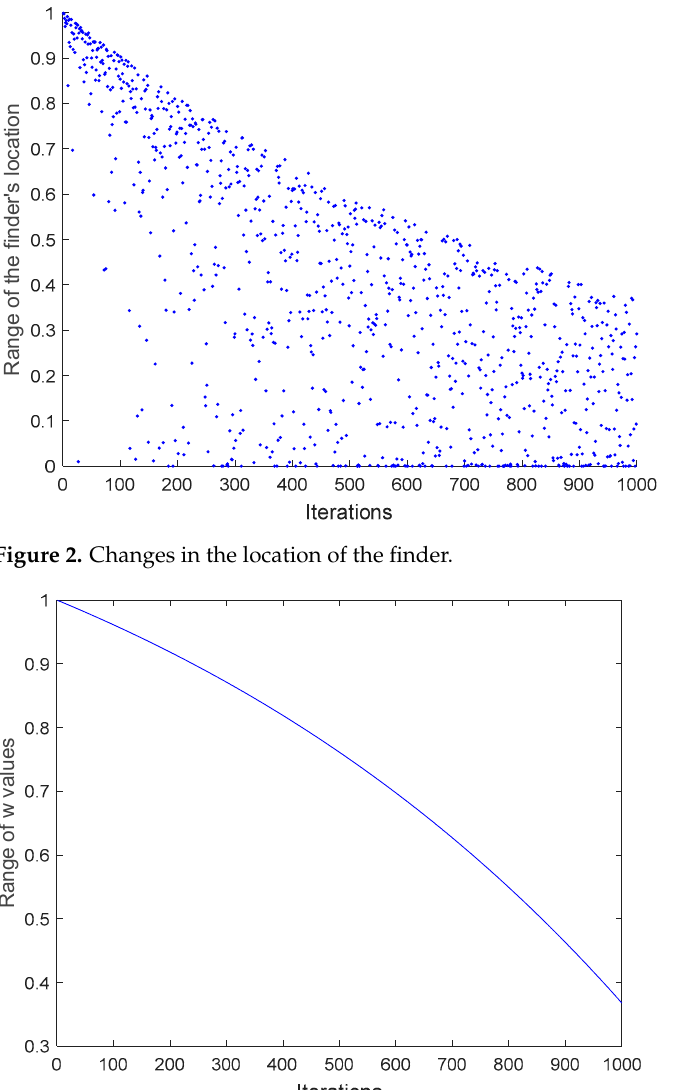
Figure 3. Iterative change of adaptive weight.